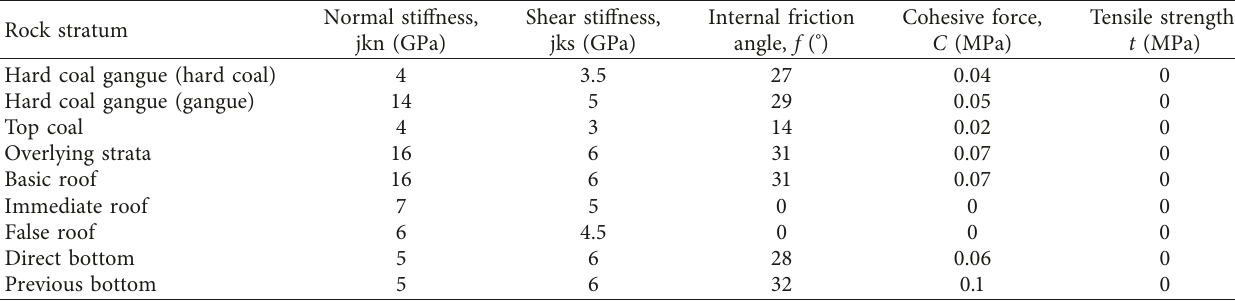
Table 3: Mechanical parameters of contact surface between hard seam and coal seam in different layers of top coal. Rock